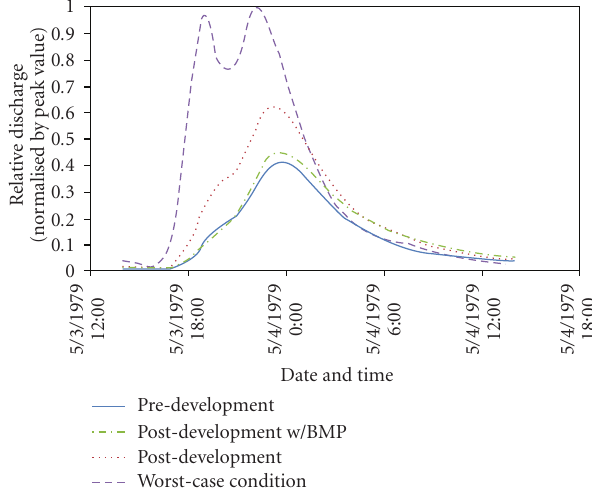
Figure 14: Tunica County Site modeled reach flow for all site